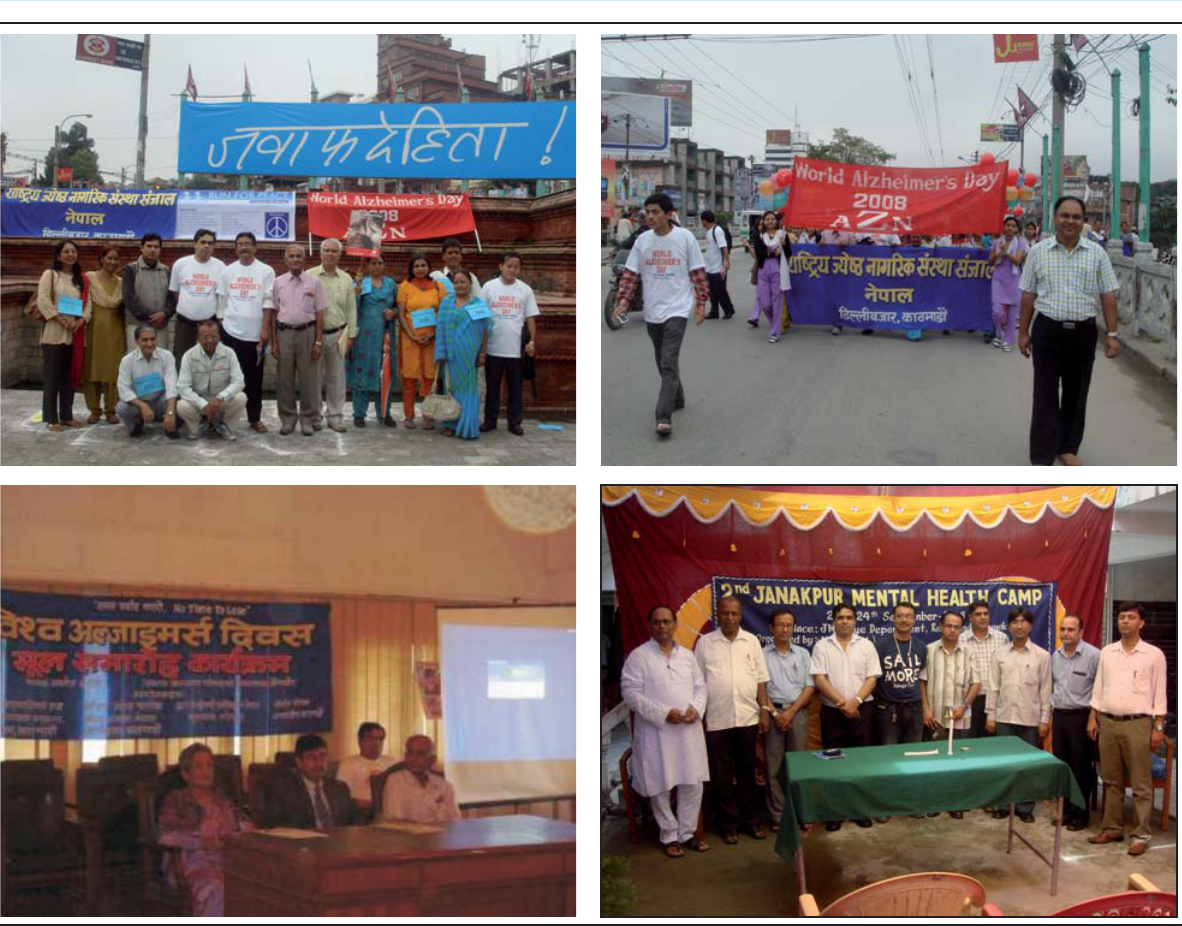
Figure 1. Highlights of the mental health Week in Kathmandu and Janakpur on 20-26 September